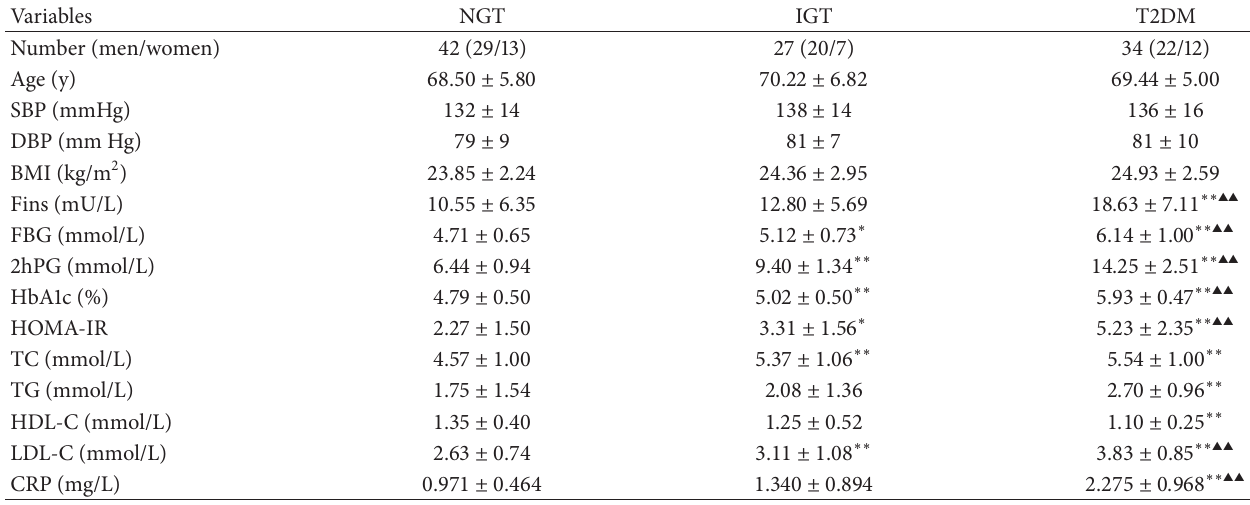
Table 1: Clinical and biochemical parameters of T2DM, IGT, and NGT